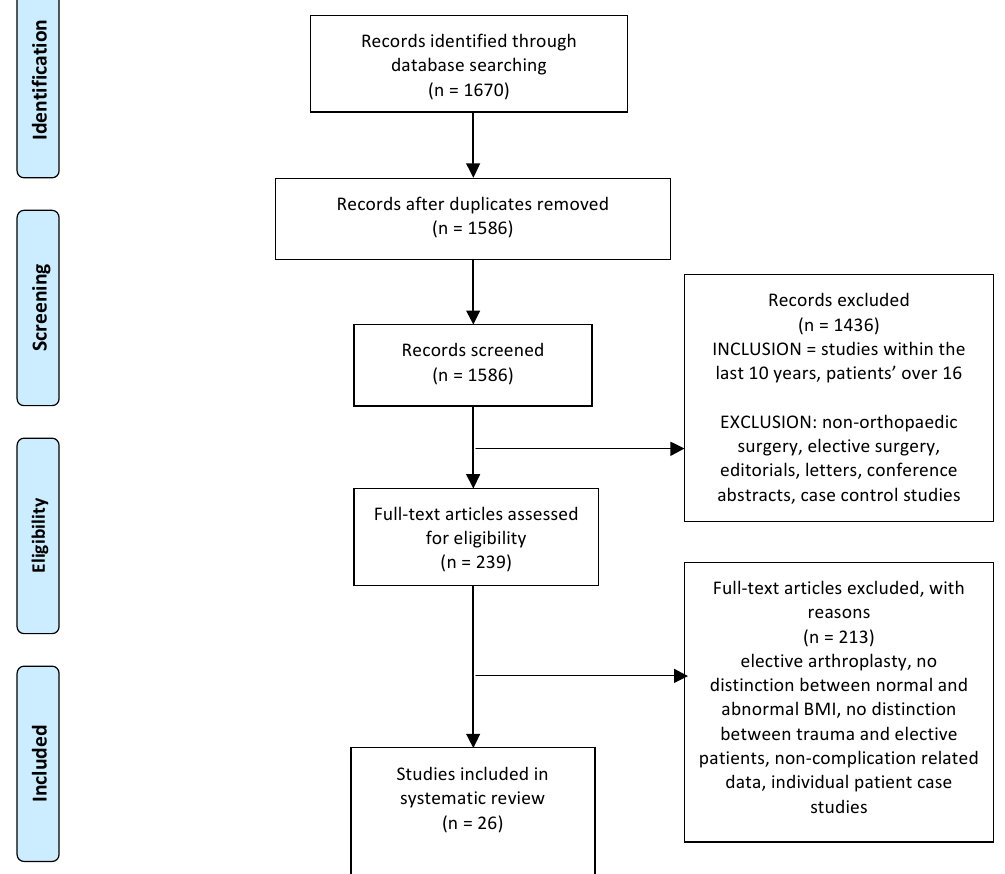
Figure 1. A literature search of abnormal body mass index (BMI), PRISMA, Preferred Reporting. Items for Systematic Reviews and Meta ‐ Analysis.